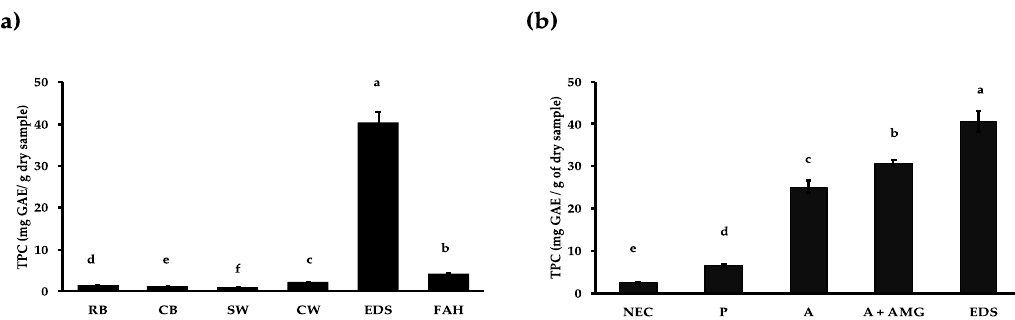
Figure 1. Total polyphenol content (TPC) in bean fractions ( a ) and during digestion with individual enzymes ( b ). TPC content was evaluated in raw beans (RB; acidified methanol extraction), cooked beans (CB; acidified methanol extraction), soaking (SW) and cooking water (CW), enzymatic digestion supernatants (EDS which refers to digestion with amylase, amyloglucosidase and protease) of cooked beans and fibre acid hydrolysis supernatant (FAH). ( b ) TPC in supernatants following digestion with protease (P), pancreatic α -amylase (A), pancreatic α -amylase and amyloglucosidase (A + AMG) and combined enzymes (EDS). No enzyme control (NEC) refers to undigested bean supernatant. Di ff erent letters indicate statistically di ff erent values among samples according to a post-hoc comparison (Tukey’s test) at p ≤ 0.05.